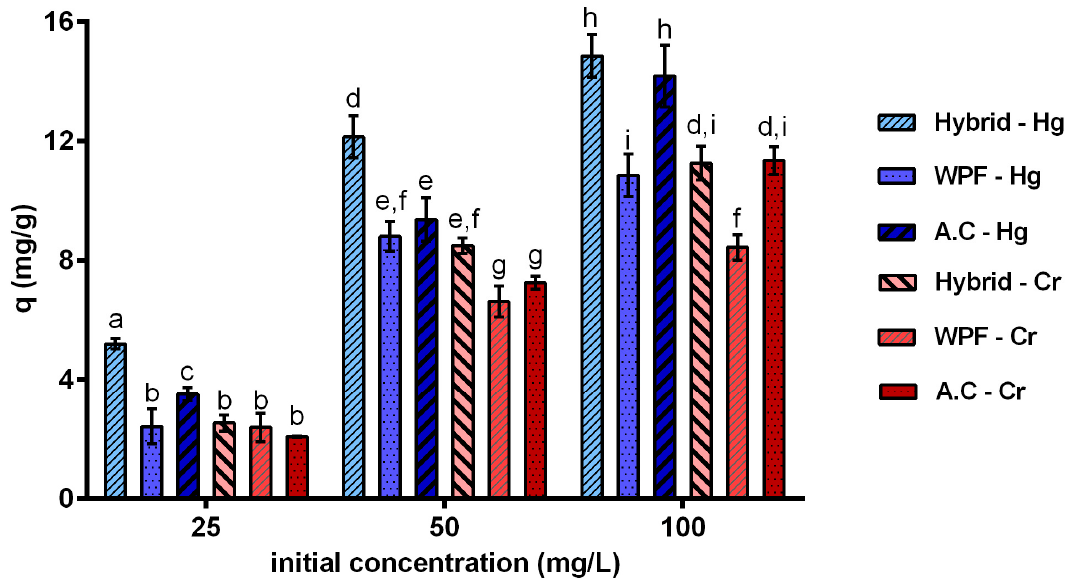
Figure 6. Adsorption capacity of membranes of AC, WPF and the Hybrid of 1:2 AC:WPF for mercury (blue bars) and chromium (red bars) at initial concentrations of 25, 50 and 100 mg / L. Error bars are standard deviations ( n = 3). Di ff erent letters on the bars indicate significant di ff erences between di ff erent treatments at p -level = 0.05 based on the least significant di ff erence (LSD) test.